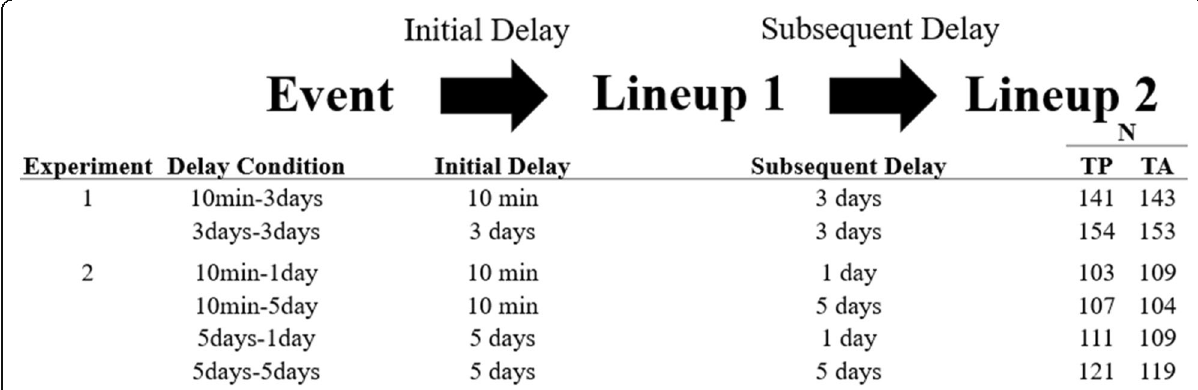
Fig. 1 The overall design of Experiments 1 and 2. The initial delay determined the length of delay between the Event and Lineup 1, and the subsequent delay determines the length of the delay between Lineup 1 and Lineup 2. All the participants saw the same lineup two times (Lineup 1 and Lineup 2). For each delay condition, the number of participants in target-present (TP) and target-absent (TA) lineup conditions is shown in the